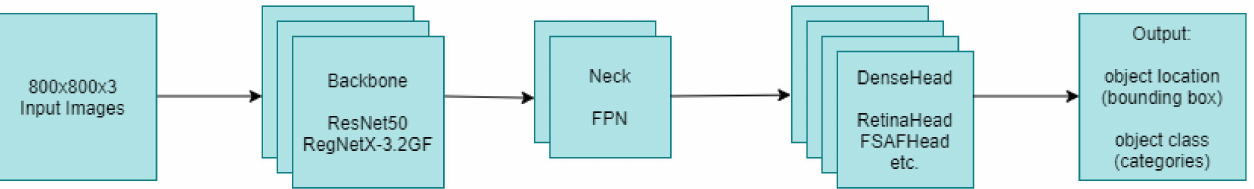
Figure 3. Single-stage object detectors (RetinaNet, FSAF, etc.).